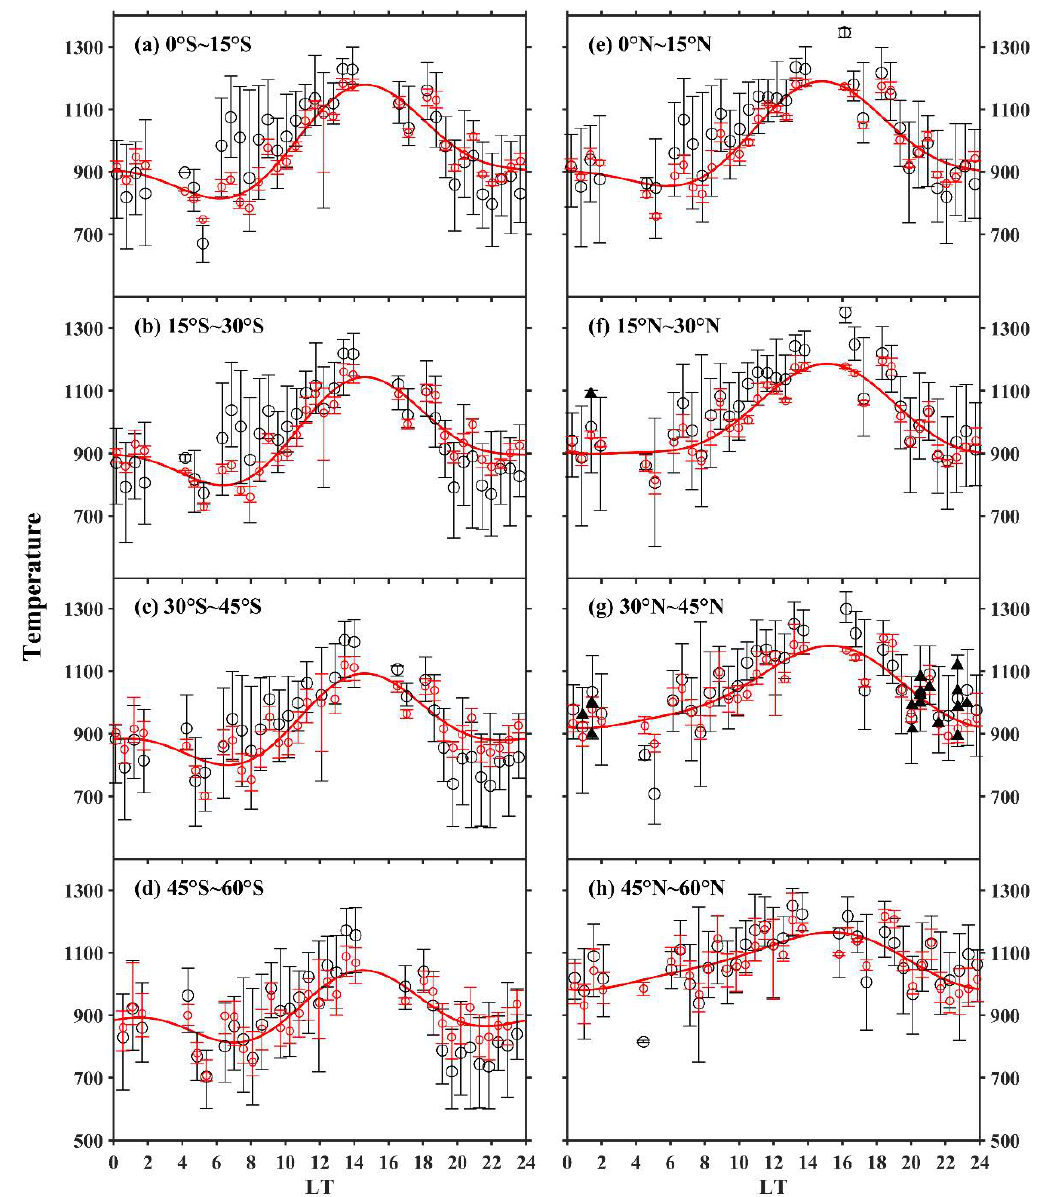
Figure 5. Diurnal variation of derived temperatures calculated with m s , model temperatures and ground-based FPI temperatures. The duration is from mid-April to early August in 2014. Black dots represent the derived temperatures, red dots represent the MSIS temperatures, red line represents the fitted curve of red dots; and black solid triangles represent the ground-based FPI temperatures during this time. The left side represents the four latitude bands of the Southern Hemisphere, and the right represents the Northern Hemisphere.